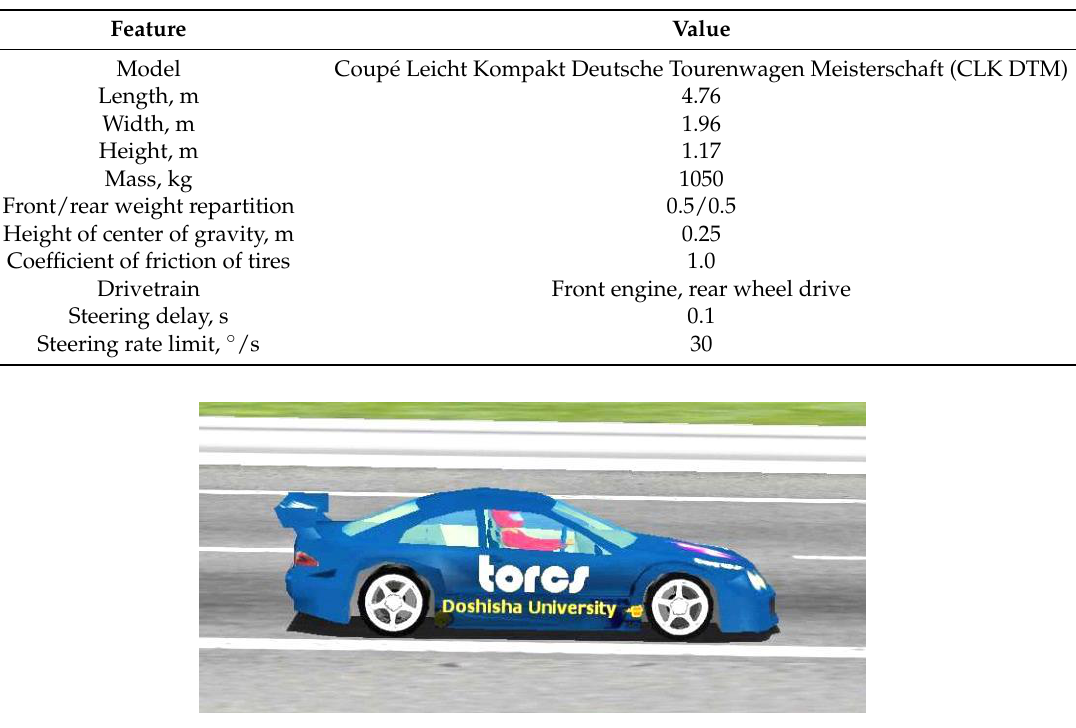
Figure 1. A snapshot of the simulated car.